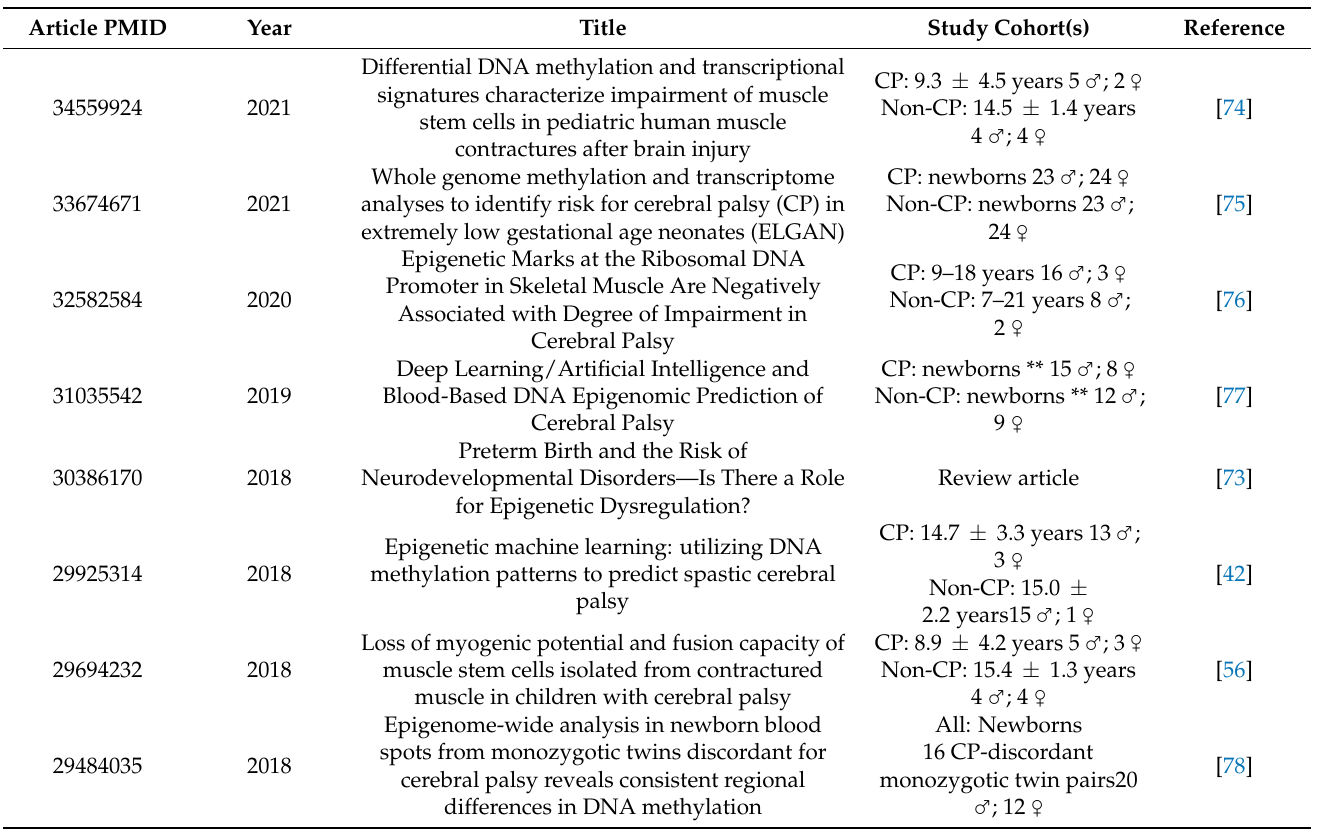
Table 1. Studies associating DNA methylation with CP